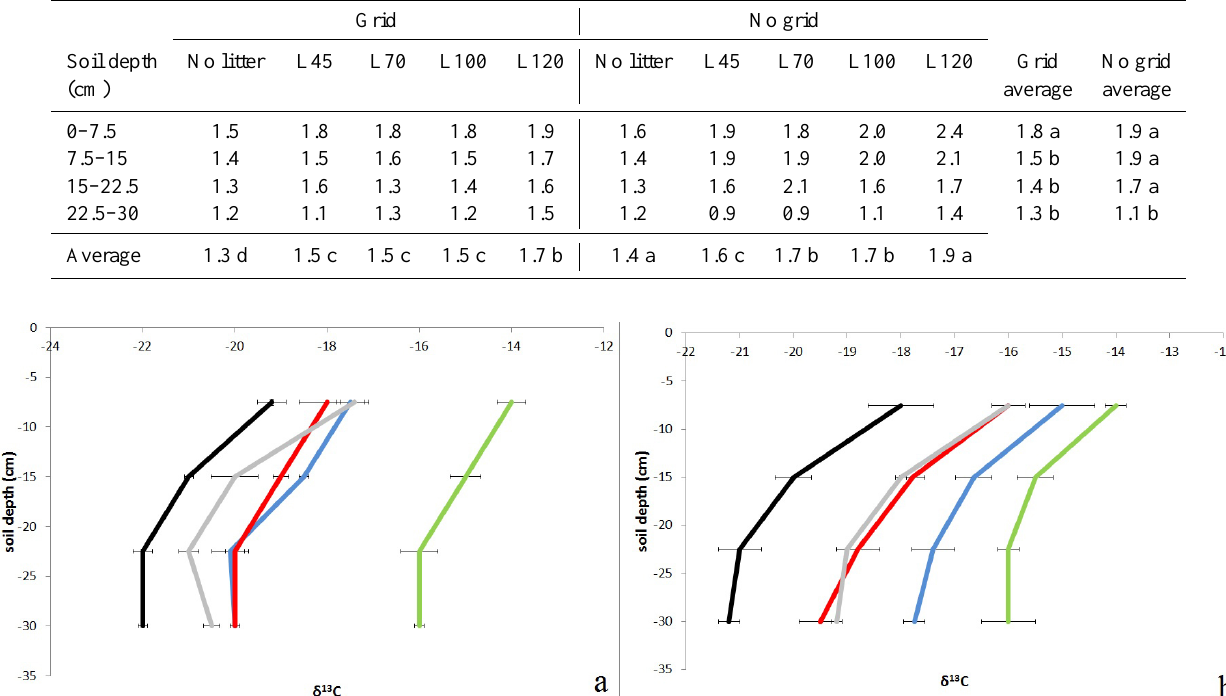
Table 3. Average of soil organic carbon (%) at different soil depths. For each treatment different letters indicate differences for P ≤ 0 . 05.